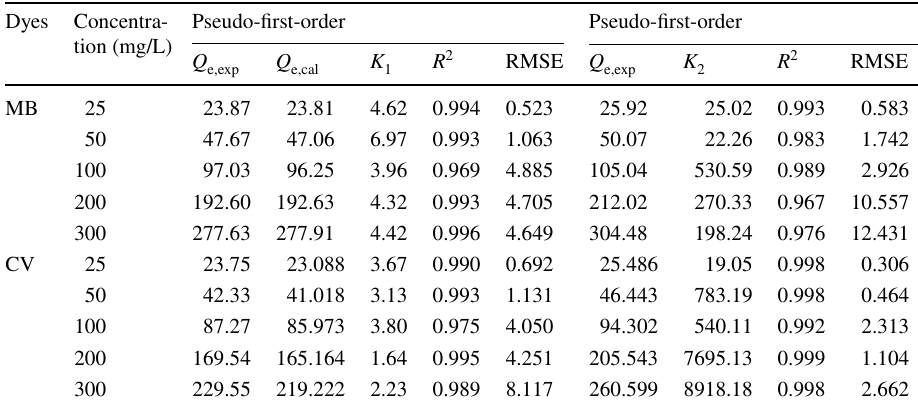
Table 2 Kinetic parameters for MB and CV adsorption onto ABent/A